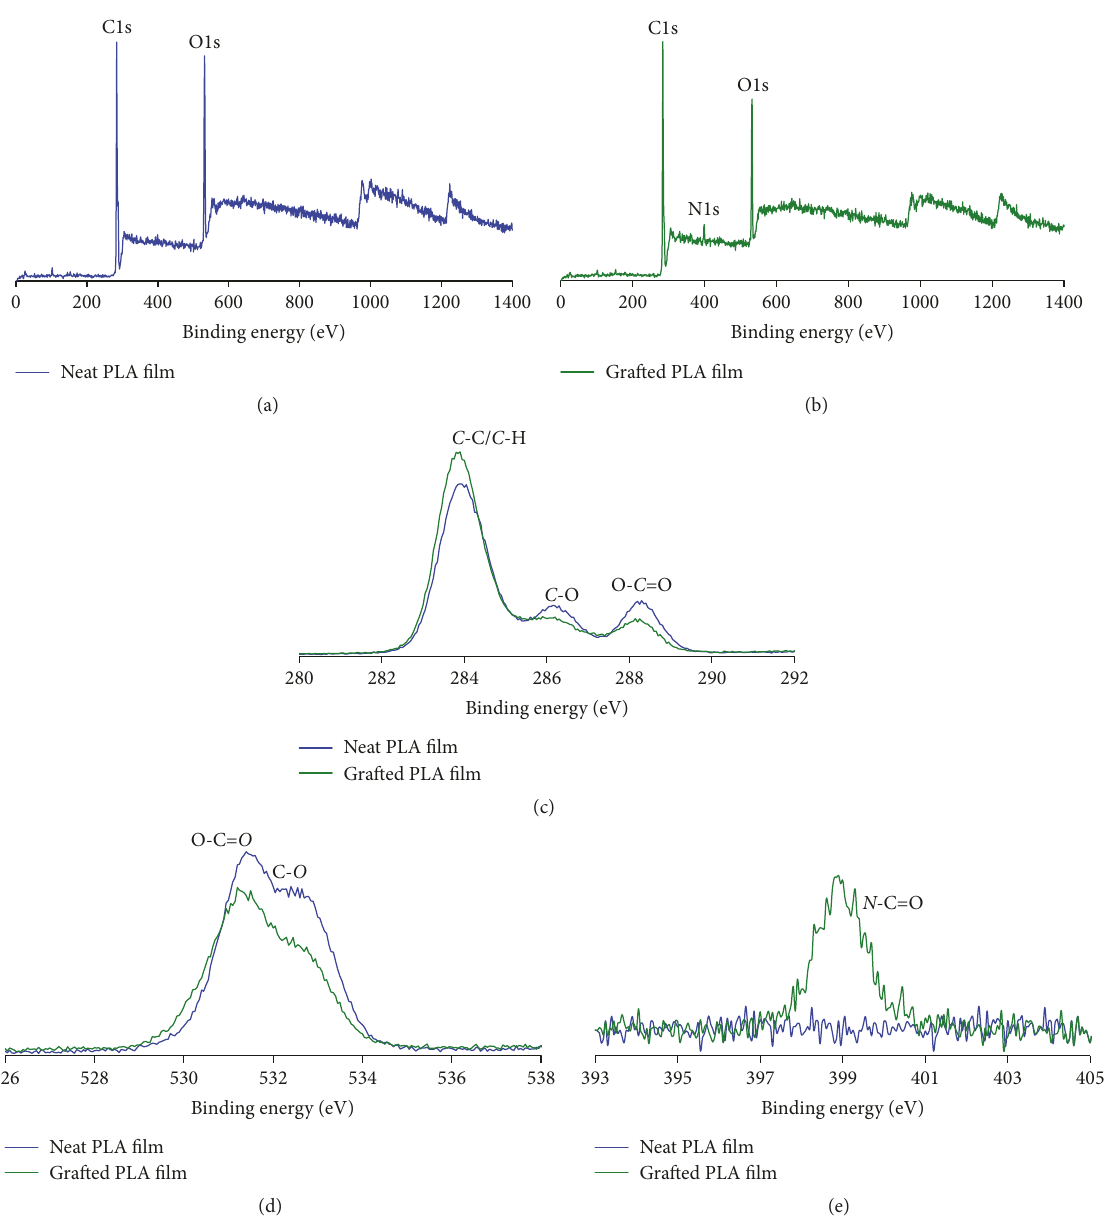
Figure 5: XPS spectra of neat (a) and grafted PLA (b) films (full spectra) and expanded scaled spectra in the C1s (c), O1s (d), and N1s (e) regions of neat and grafted PLA